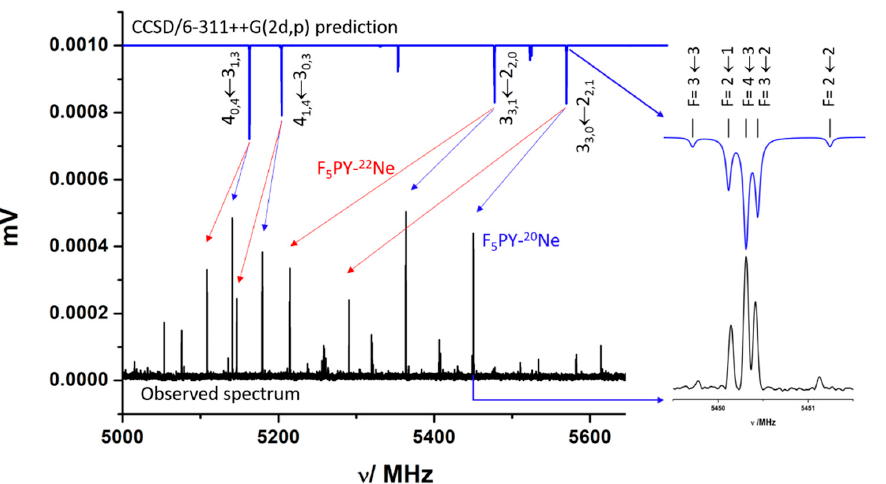
Figure 1. A section of the CP-FTMW spectrum in the 5.0–5.6 GHz region recorded from a supersonic jet expansion of F 5 PY diluted in Ne. The comparison with the prediction of the spectrum carried out from the rotational parameters predicted at CCSD/6-311++G(2d,p) (upper blue inverted trace) for F 5 PY-Ne complex helps to identify the patterns of the 4 0,4 ← 3 1,3 , 4 1,4 ← 3 0,3 and 3 3,1 ← 2 2,0 , 3 3,0 ← 2 2,1 doublets for both the parent (blue arrow) and 22 Ne (red arrow) isotopologues. The excerpt compares the observed and predicted 14 N quadrupole coupling hyperfine structure for the 3 3,0 ← 2 2,1 transition where the components are identified by the quantum number F, taking values from (J + I) to (J − I) reflecting the coupling between the overall rotation moment (J) and 14 N nuclear spin moments (I = 1).